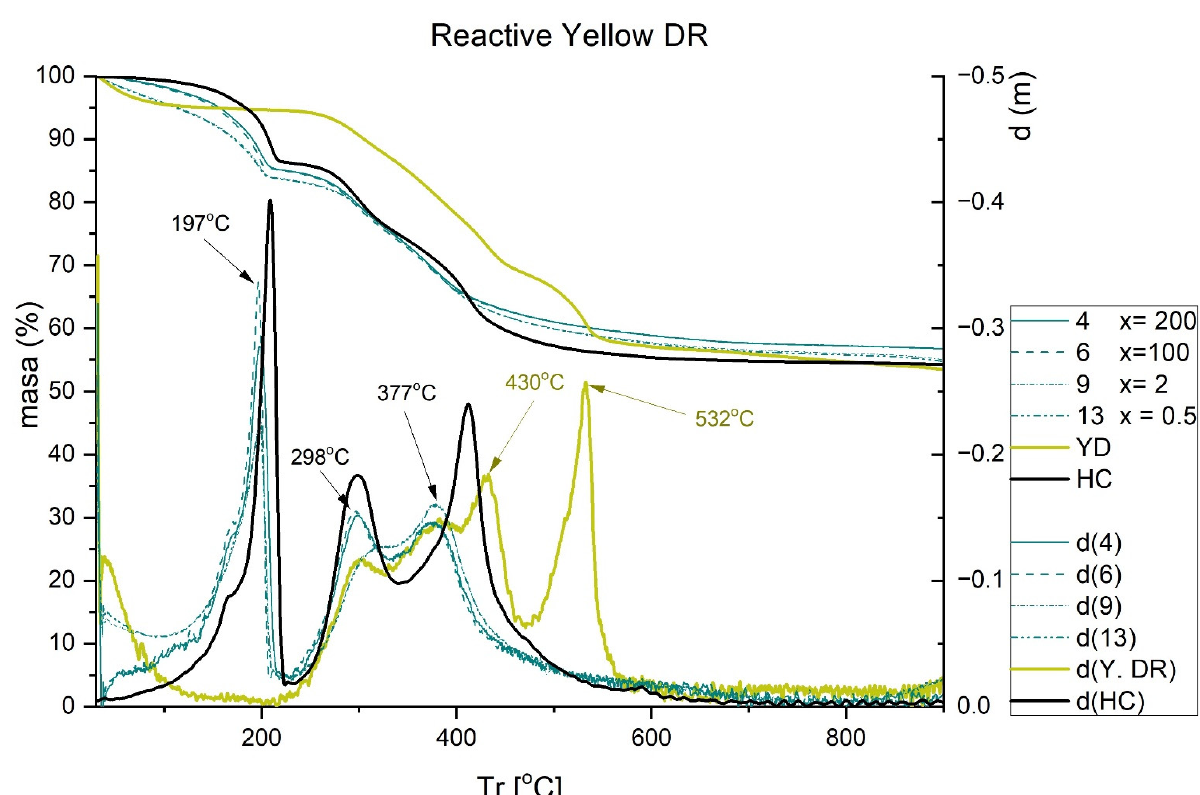
Figure 10. TGA and DTGA of Reactive Yellow DR free and